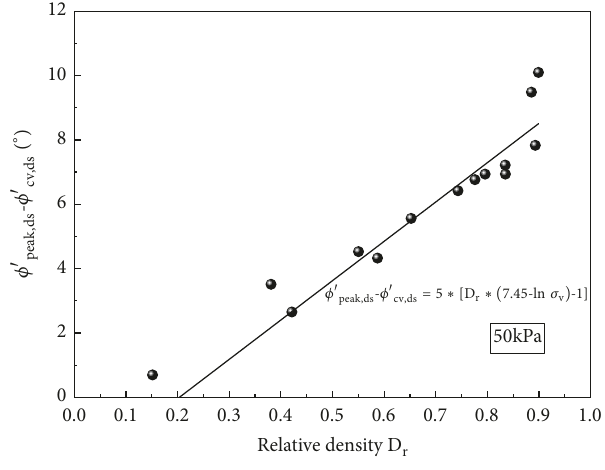
Figure 13: Relationship between 𝜙 󸀠 𝑝𝑒𝑎𝑘,𝑑𝑠 − 𝜙 󸀠 𝑐 V ,𝑑𝑠 and relative density ( 𝜎 󸀠 V = 50